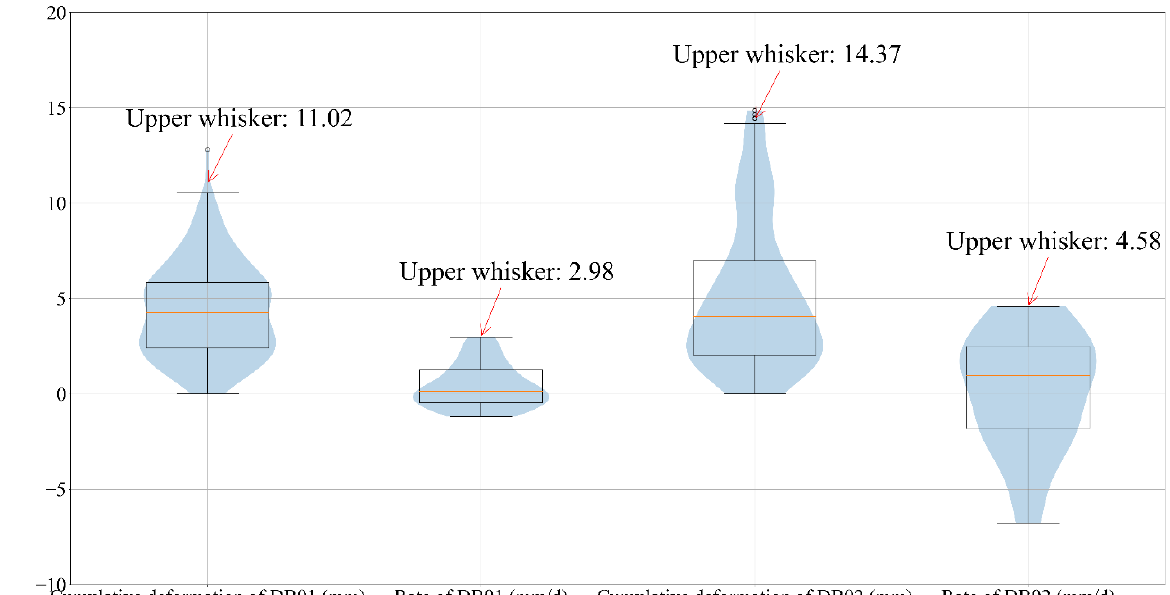
Figure 5. Cumulative displacement and velocity distribution of each monitoring station of the Lish-